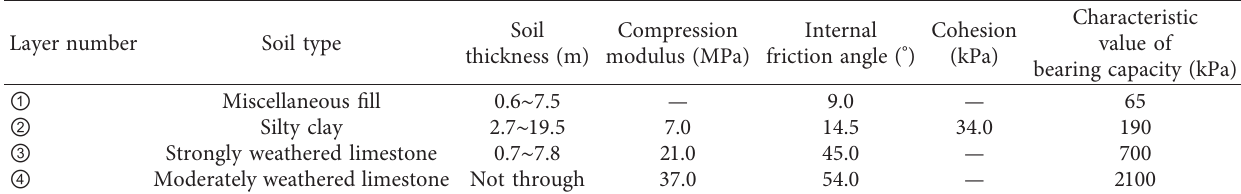
Table 2: Geophysical and mechanical parameters of soil layers.